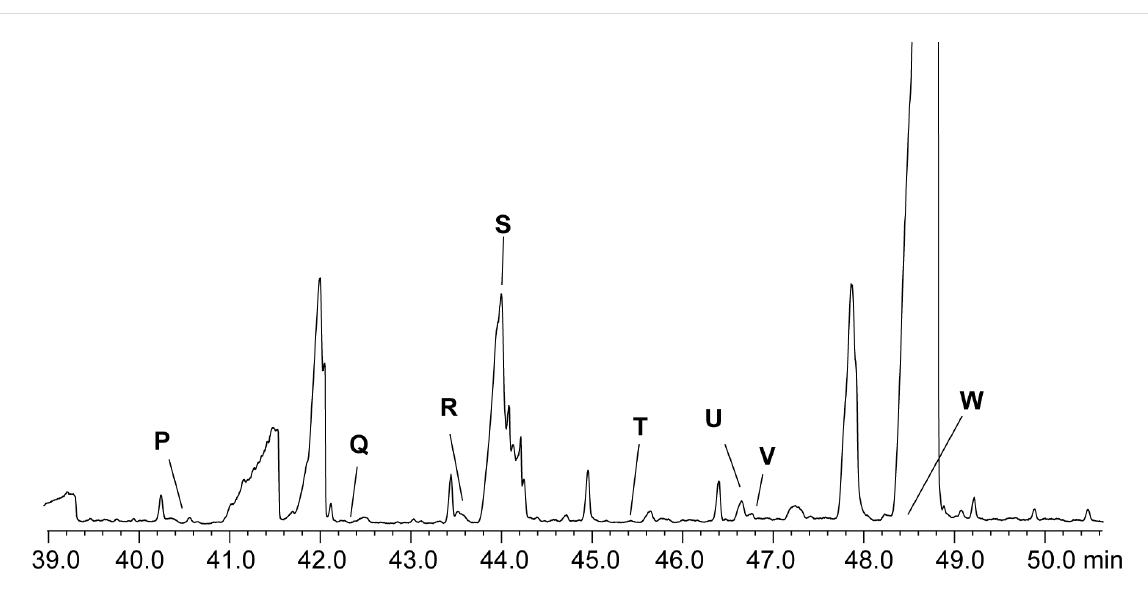
pounds (Table 2). Overall, six saturated and unsaturated com- pounds with a chain length between C 14 and C 19 were detected. The roughly 100 retention index units between the members of this homologous series indicated that the acyl chains are unbranched. Additionally, two unsaturated glycine derivatives were present, 9-C16:1-NAGME ( 11 ) and C18:1-NAGME (Table